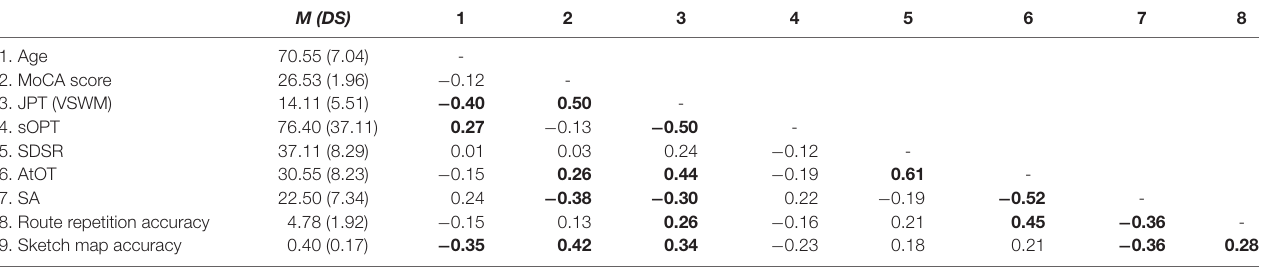
TABLE 1 | Means and standard deviations of the variables and their